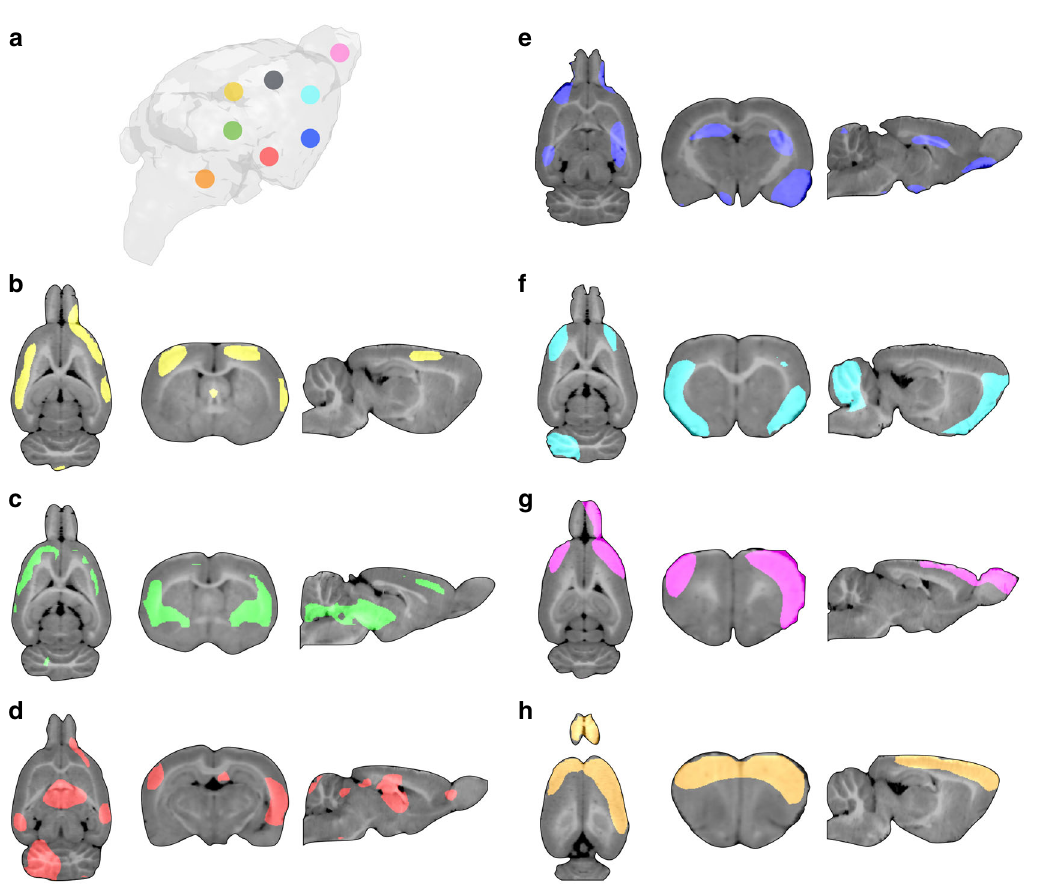
Fig. 5 Amyloid- β (A β ) is associated with distant within-network hypometabolism in transgenic A β rats. a 3D brain representation of the regions-of-interest in which the A β values were obtained. Statistical parametric maps, overlaid on a structural MRI template, show the brains regions where voxel-wise glucose metabolism was negatively associated with A β load in the ( b ) retrosplenial (yellow), ( c ) medial temporal (green), ( d ) lateral temporal (red), ( e ) inferior parietal (blue), ( f ) frontoparietal (light blue), ( g ) olfactory bulb (pink), and ( h ) cerebellar (orange) cortices in transgenic A β rats ( n = 10). A β in the somatosensory cortex (gray dot) did not signi fi cantly associate with hypometabolism. Parametric images were FWER corrected at P < 0.05 and adjusted for age, gender, and gray matter